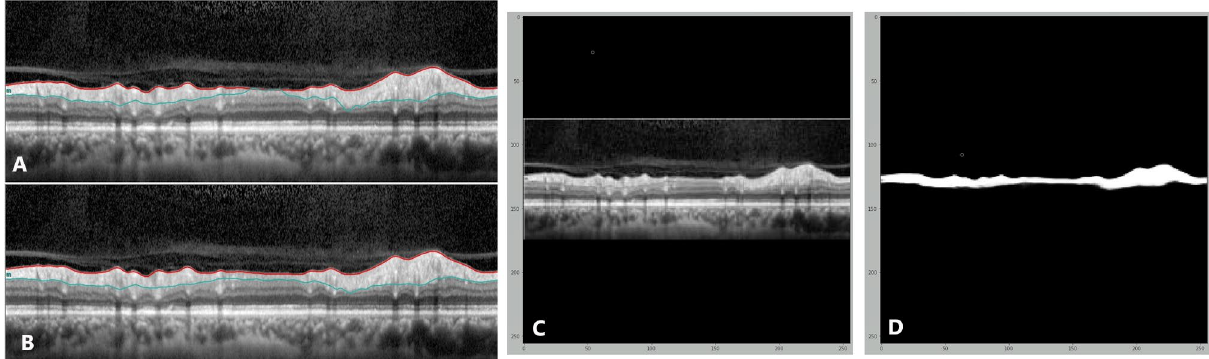
Figure 3. Sample OCT image of an eye with ischemic optic neuropathy. Retinal nerve fiber layer segmentation by OCT machine with error ( A ) and after manual correction ( B ). ( C ) The image input for our U-Net and (D)